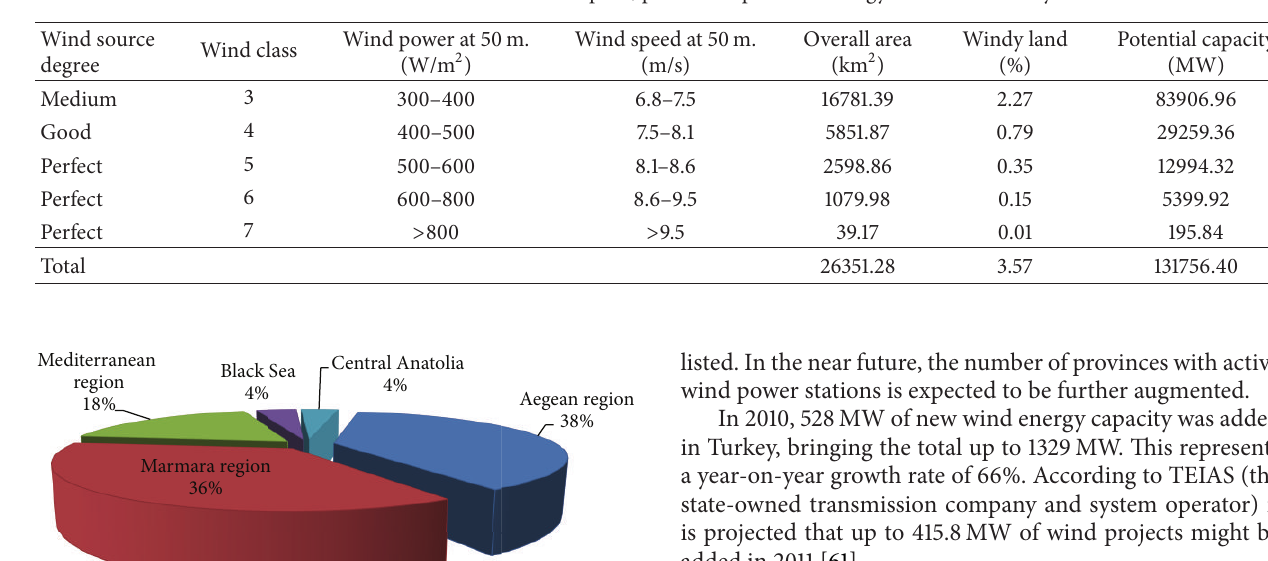
Table 2: Areal distribution of wind speed, power and potential energy amount in Turkey.